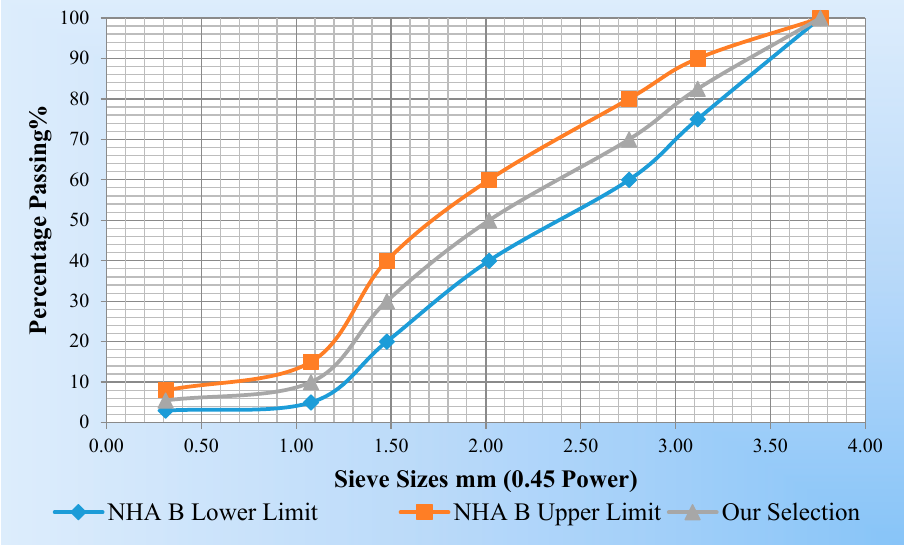
Figure 4. The NHA class-B gradation curve.